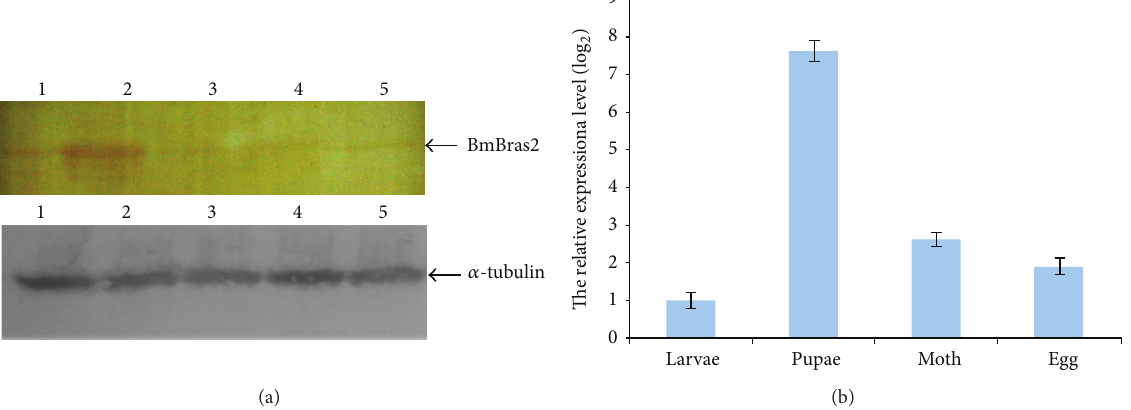
Figure 3: The expression analysis of BmBras2 during different silkworm developmental stages. (a) The expression levels of BmBras2 by western blotting; 1, fifth instar larvae; 2, pupae; 3, moth; 4, egg; 5, purified rBmBras2. (b) The relative expression levels of BmBras2 analyzed by real-time PCR. The relative expression level was calculated by using 2 −ΔΔ CT , where ΔΔ CT = (CT, BmBras2 -CT, 18S rRNA) for different stages and (CT, BmBras2 -CT, 18S rRNA)